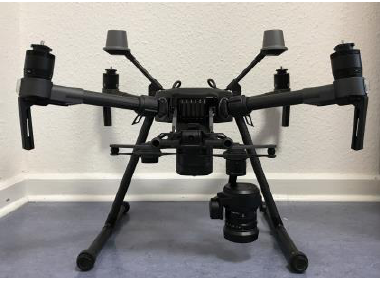
Figure 1b. DJI Matrice 210 v2 RTK